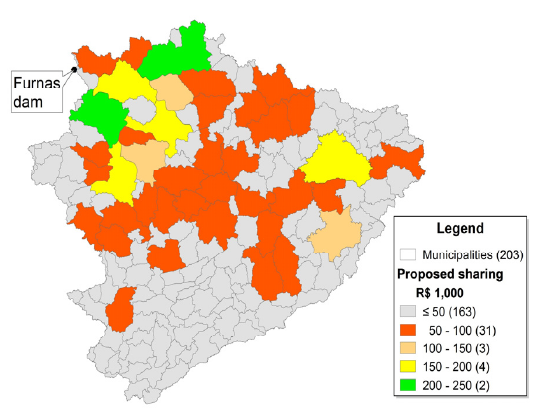
Figure 5. Apportionment of Furnas royalties, based on the net falling height and water